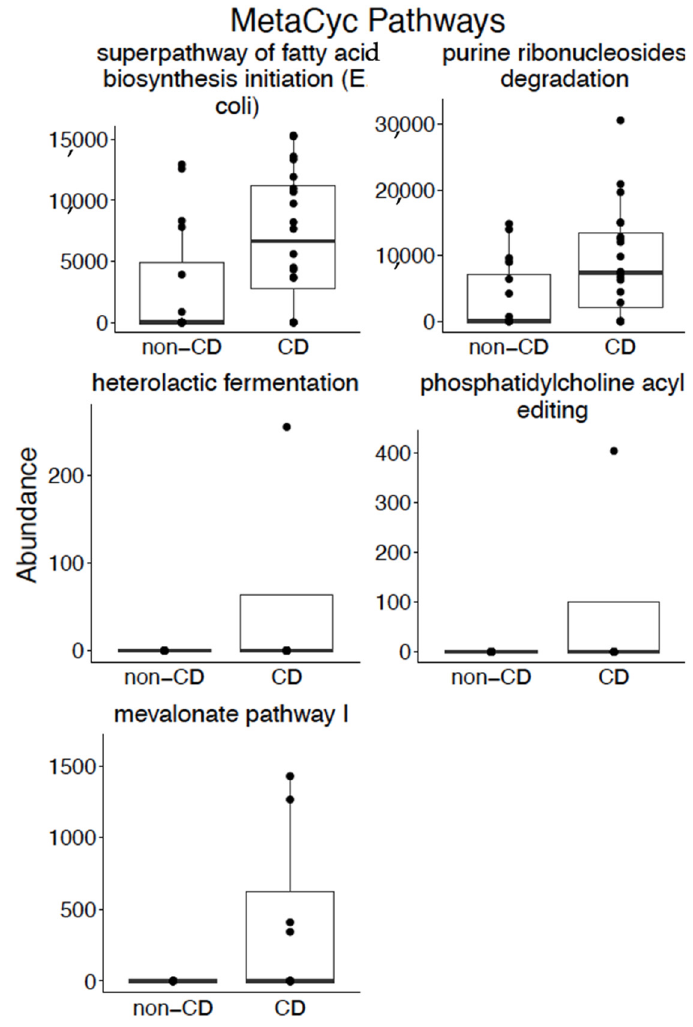
Figure 4. Cross-sectional analysis of MetaCyc pathways in the breast milk of subjects with CD on a gluten-free diet compared with healthy controls. Pathways with a statistically significant difference in abundance between the breast milk of subjects with CD on a gluten-free diet and healthy controls according to Mann–Whitney U test (Wilcoxon rank-sum test) ( p -value < 0.05).